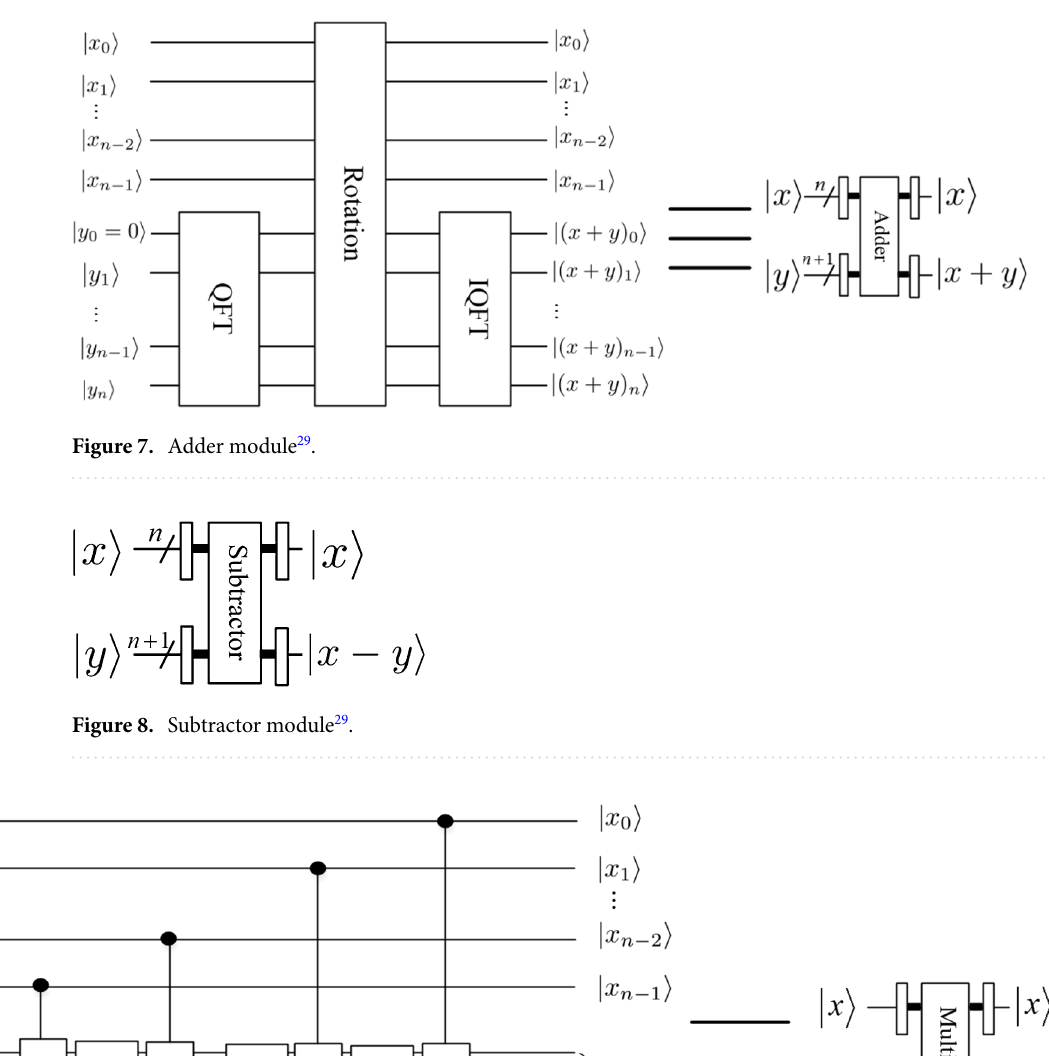
Figure 9. Multiplier module 29